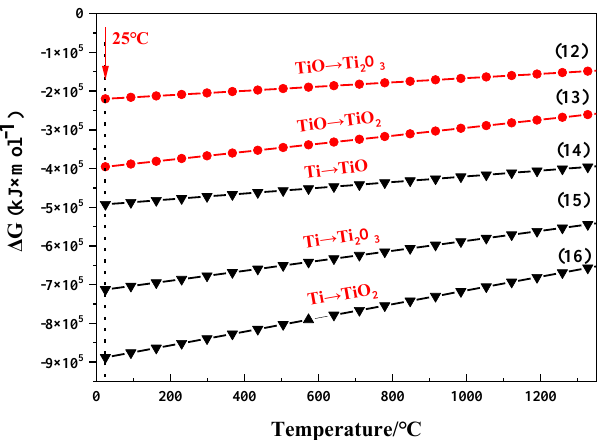
Figure 8. Relationship between Gibbs free energy-temperature of oxidation reaction of Ti.